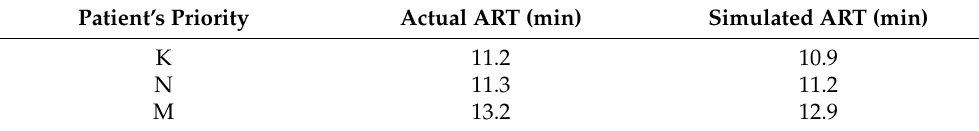
Table 1. Actual and simulated average response times (ART) in Slovakia. Patient’s